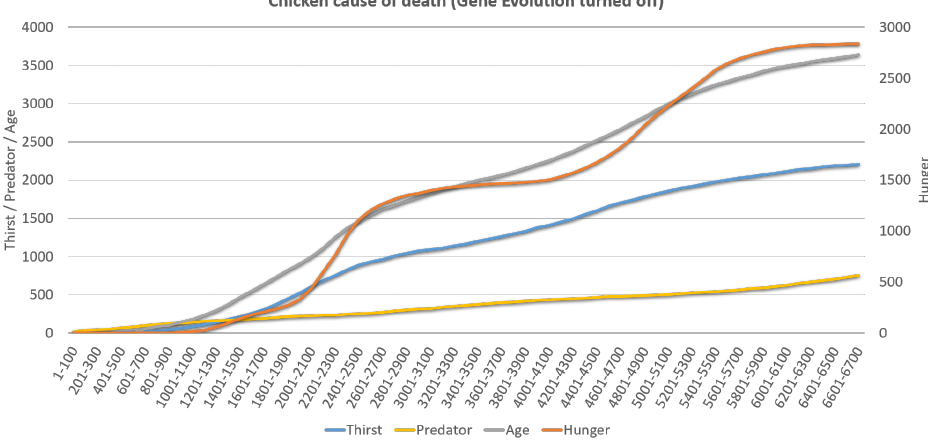
Figure 18. The diagram shows the cause of deaths for the Chicken population without